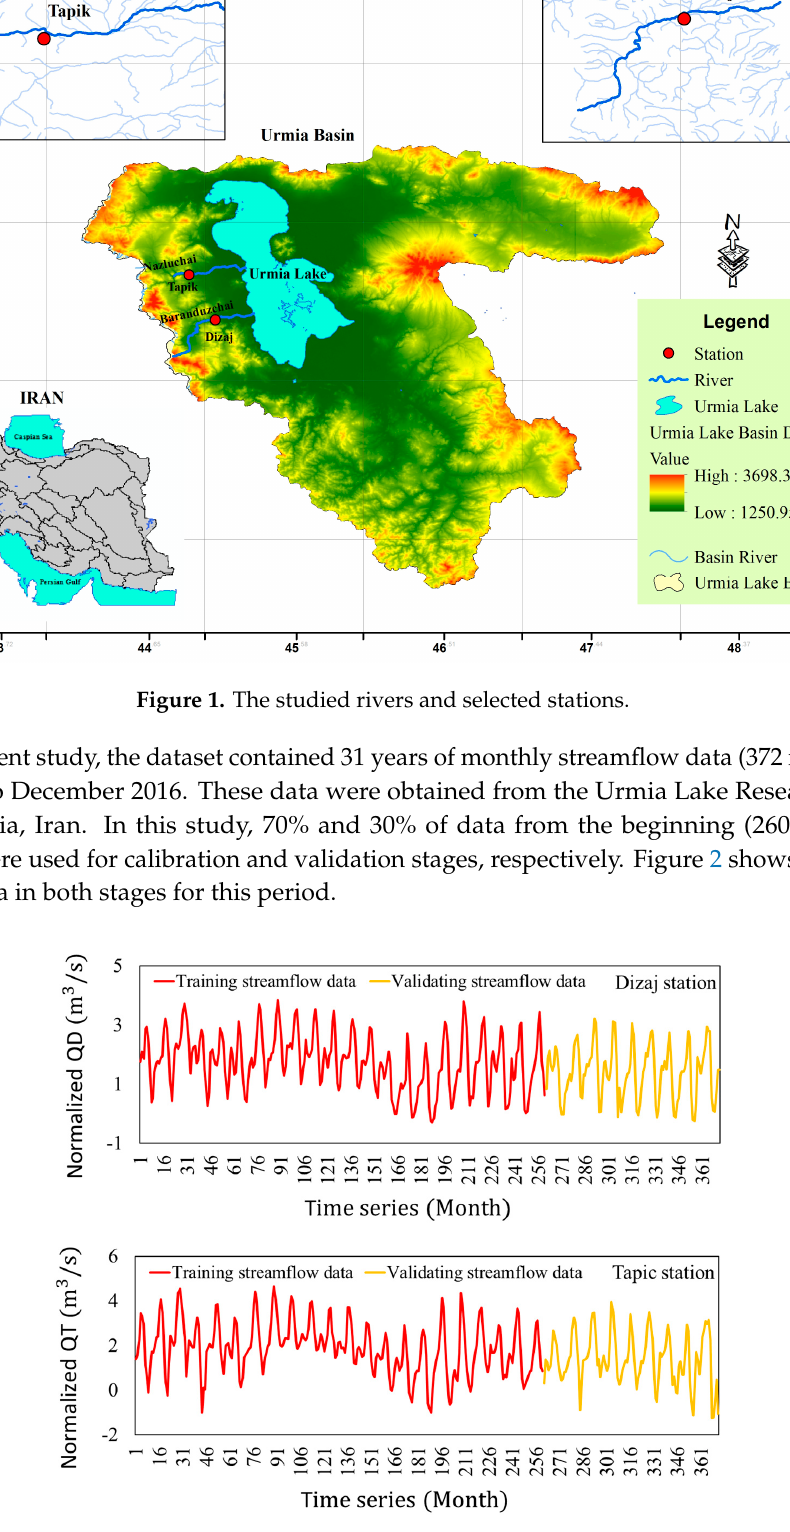
Figure 2. Monthly normalized streamflow data for Dizaj and Tapik stations during 1986–2016 in calibration and validation